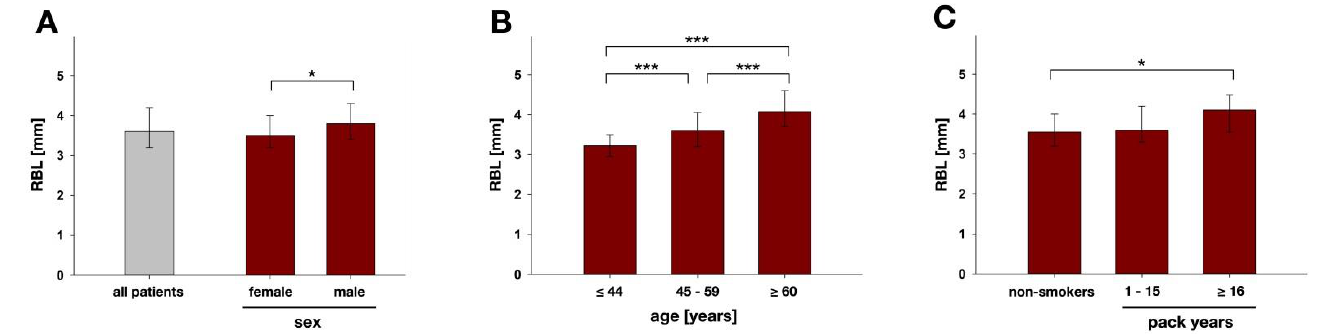
Figure 3. Results of RBL analysis for ( A ) all patients ( n = 163) and divided into male ( n = 63) and female ( n = 100) and according to ( B ) the different age-groups ( ≤ 44 y, n = 42; 45–59 y, n = 65; ≥ 60 y, n = 56) and ( C ) smoking groups (non-smokers, n = 131; 1–15 py, n = 15; ≥ 16 py, n = 17). Results are depicted as medians, first and third quartiles and asterisks depict statistically significant differences between the groups. * marks significant differences with p ≤ 0.05; *** marks significant differences with p ≤ 0.001.